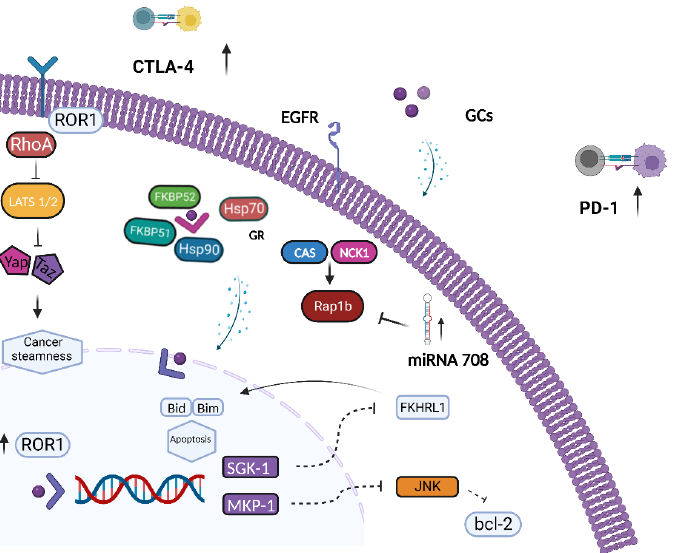
Figure 2. Upon cortisol binding, the glucocorticoid receptor enhances SGK-1 and MKP-1 expression to suppress ovarian cancer cell apoptosis. SGK1 has been hypothesized to phosphorylate FKHRL1, leading to its cytoplasm translocation, thereby preventing BID and BIM genes expression. The MKP1/DUSP1 gene encodes for a MAPK phosphate that preferentially inhibits p38MAPK and JNK transduction pathways, thereby resulting in decreased anti-apoptotic protein BCL-2 levels. Moreover, glucocorticoid-mediated signaling induces ROR1 expression, which in turn promotes a cancer stemness phenotype via RhoA, YAP/TAZ, and BMI-1 downstream upregulation. Additionally, GR eventually facilitates cancer immune evasion by enhancing the expression of both PD-1 on T-cells and NK-cells and CTLA-4 on activated CD4+ and CD8+ T-cells. Conversely, GR signaling increases miR-708 levels, thus resulting in impaired OC cell dissemination through targeting EGFR downstream effector Rap1B. Created with BioRender.com.